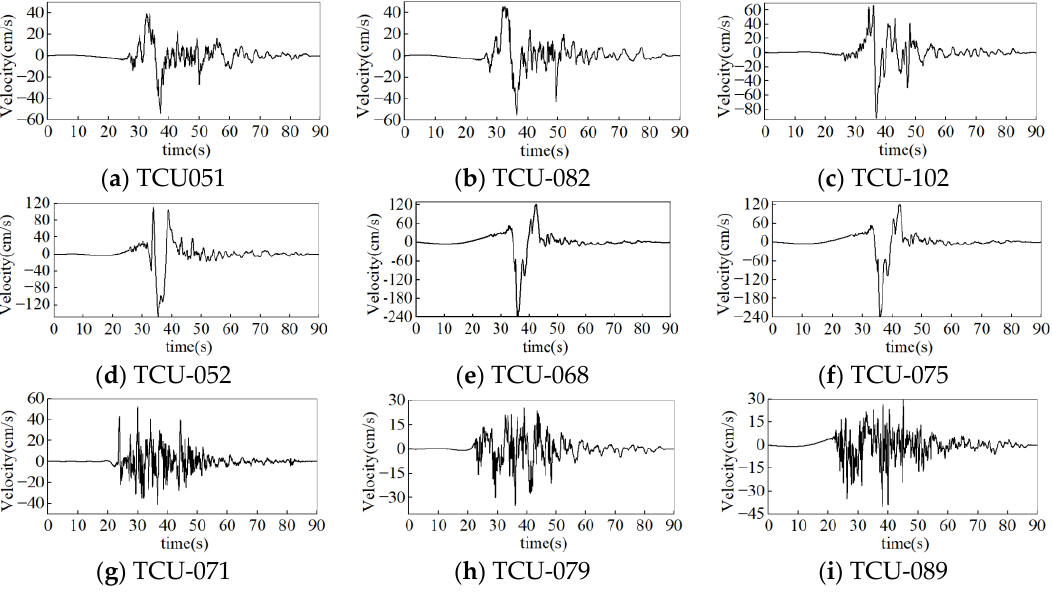
Figure 1. Velocity time history curve of ground motions. Table 1. Characteristics of different types of ground motions.